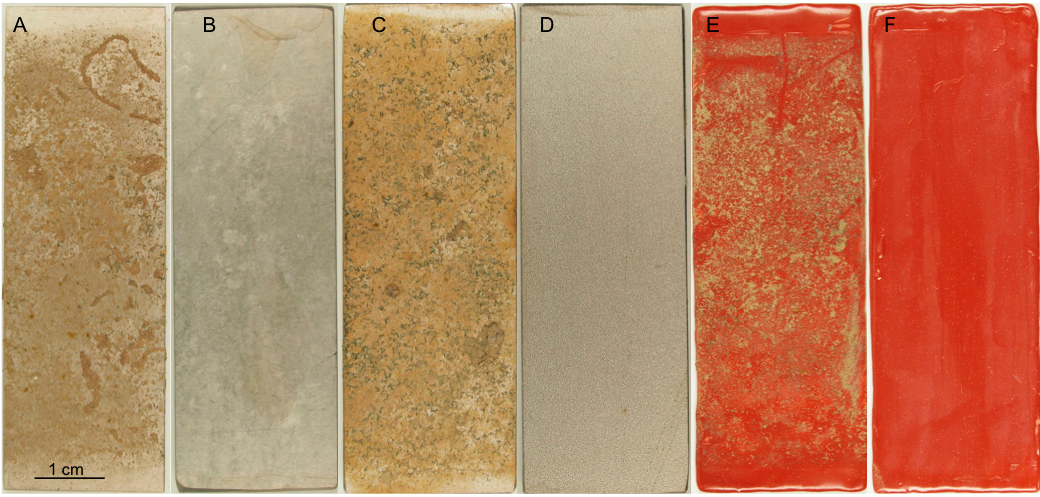
Figure 1. Photographs, showing the specimen surfaces after the three-month test. ( A , B ) 254SMO; ( C , D ) Ti alloy; ( E , F ) Inerta160-coated steel. Non-chlorinated: ( A , C , E ); chlorinated: ( B , D , F ).